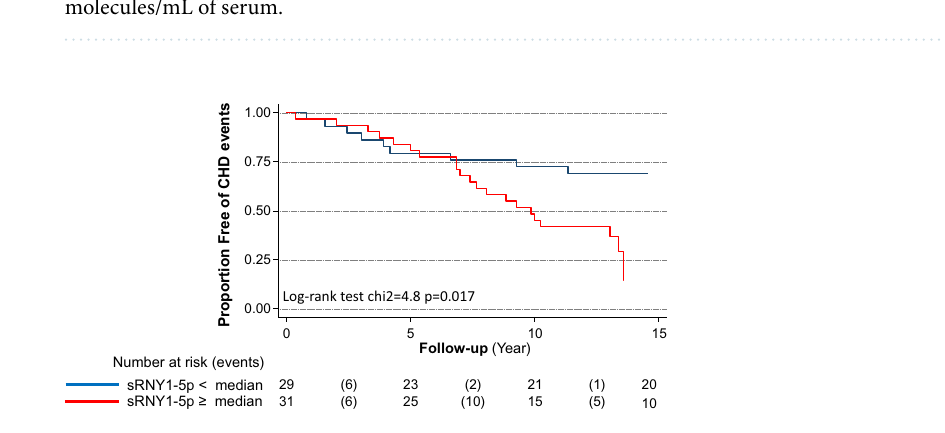
Figure 3. Predictive value of serum s-RNY1-5p for CHD events. Kaplan–Meier probability curves to encounter CHD events according to s-RNY1-5p level, above or below the sRNY1-5p median value (631 molecules/mL). Number at risk refers to the number of individuals who are still CHD-free every 5 years with the number of CHD events in